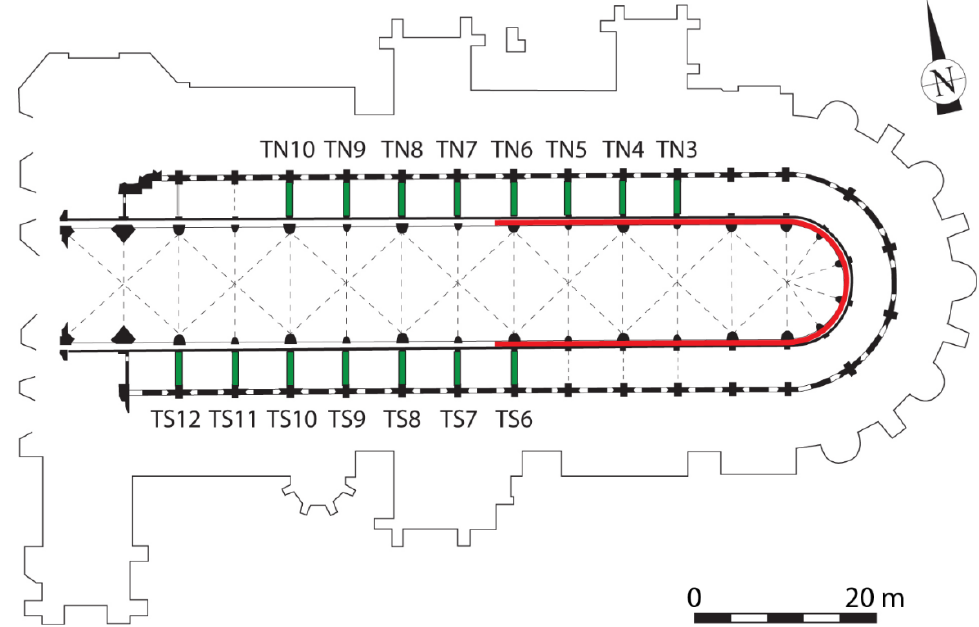
Figure 1. Map of Bourges Cathedral showing the studied iron reinforcements: attic tie-rods in green and triforium chain in red. Drawing from the authors after Férauge and Mignerey [26].